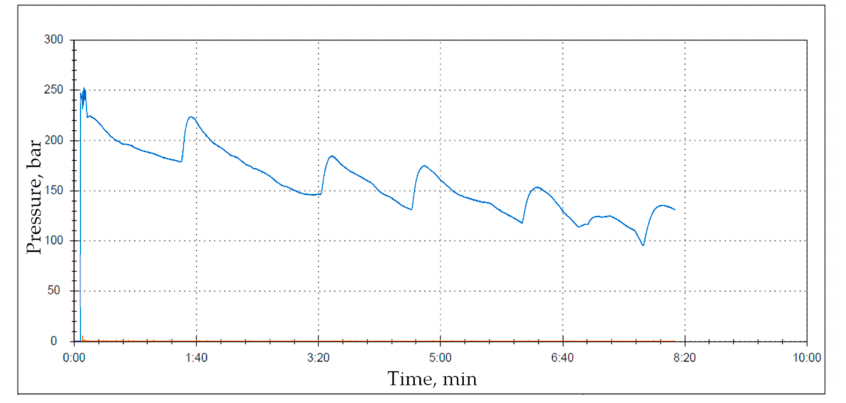
Figure 9. Measurement of pressure in the sub-piston space of the prop taking into account leakage. However, in the second phase of the study (Figures 10 and 11), the time was extended to about 10 min, which allowed for a more optimal measurement than shown in Figure 9. The measurements show a pressure drop due to an internal leak at a set pressure of 250 bar.